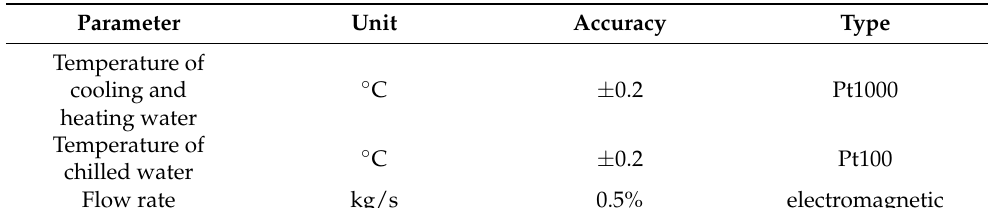
Table 3. Technical data of the measuring instruments.